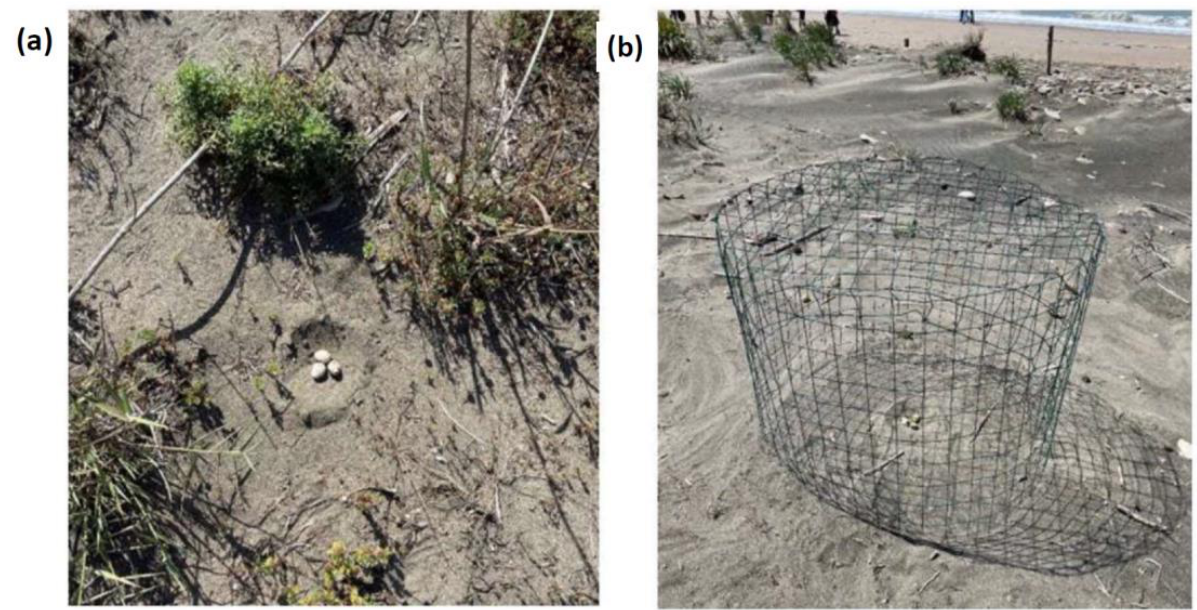
Figure 1. False nest with quail eggs without (( a ), left) and with (( b ), right) anti-predator cage (Photo: S. Vanadia).